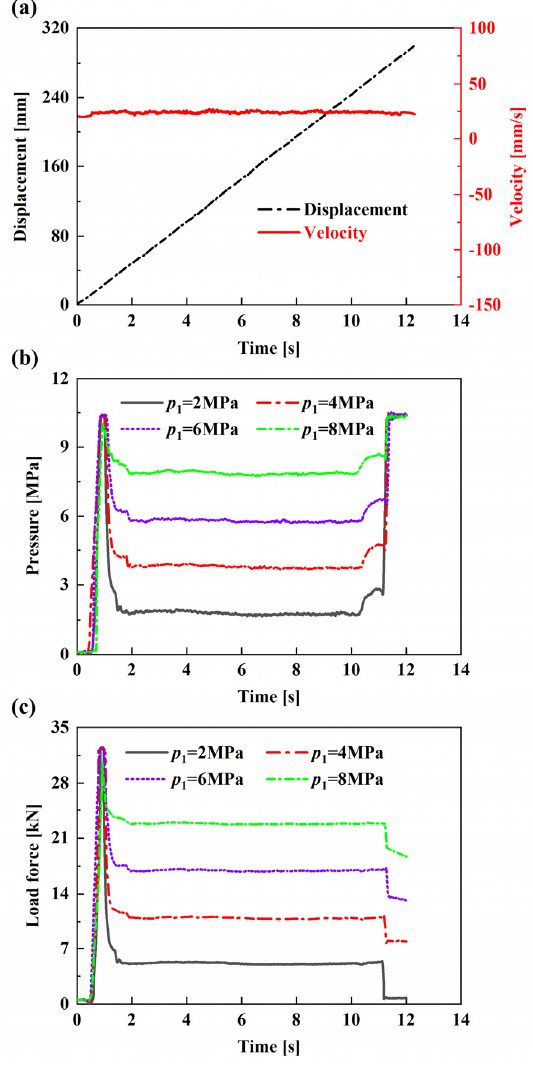
Figure 14. Experimental data: ( a ) Piston rod displacement; ( b ) rodless chamber pressure; ( c ) load force.